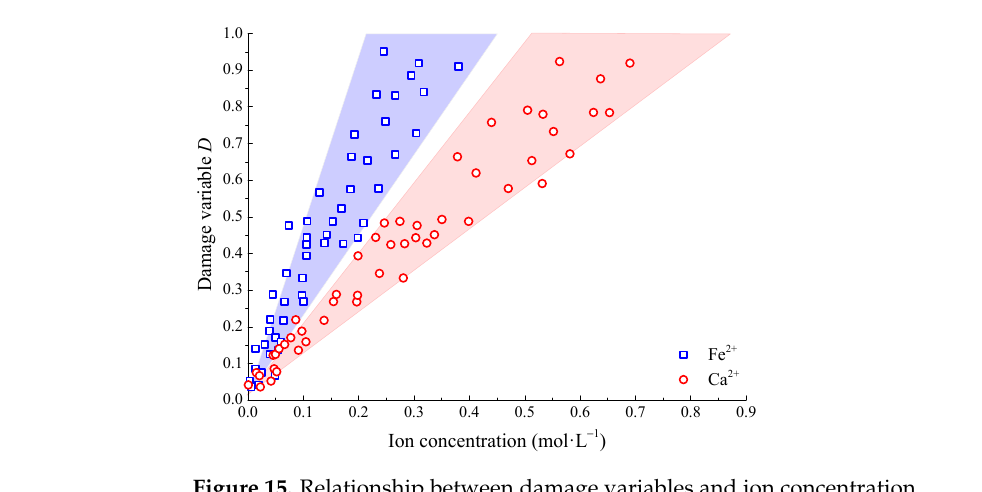
Figure 15. Relationship between damage variables and ion concentration.